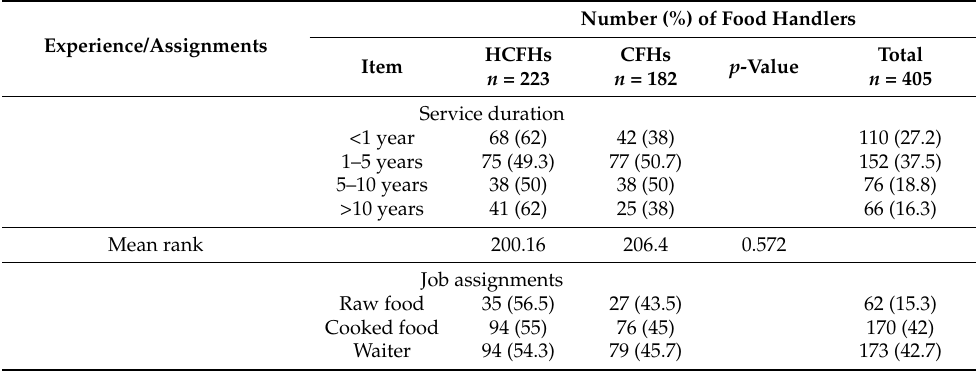
Table 2. Work experience and type of food-related assignments handled by the healthcare and community food